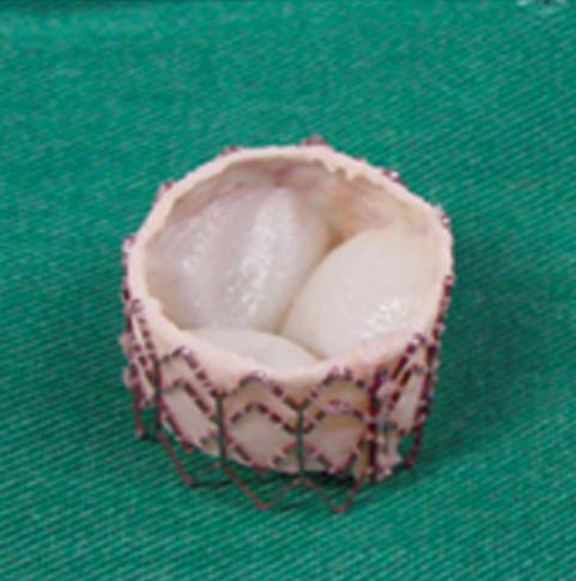
Fig. 1 - Dispositivo balão-expansível para implante em posição aórtica Critérios de